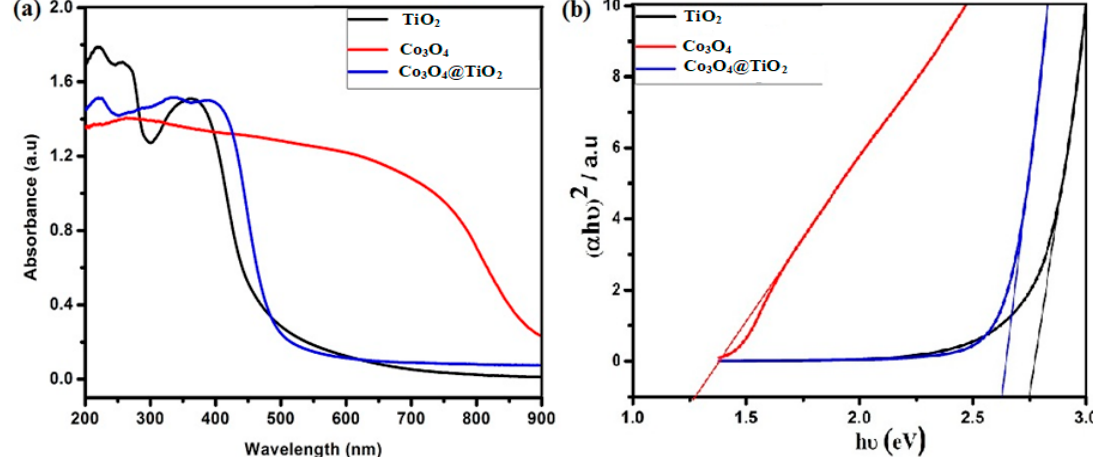
Figure 2. ( a ) UV-Vis spectra; ( b ) Tauc plot of Co 3 O 4 , TiO 2 , and Co 3 O 4 @TiO 2